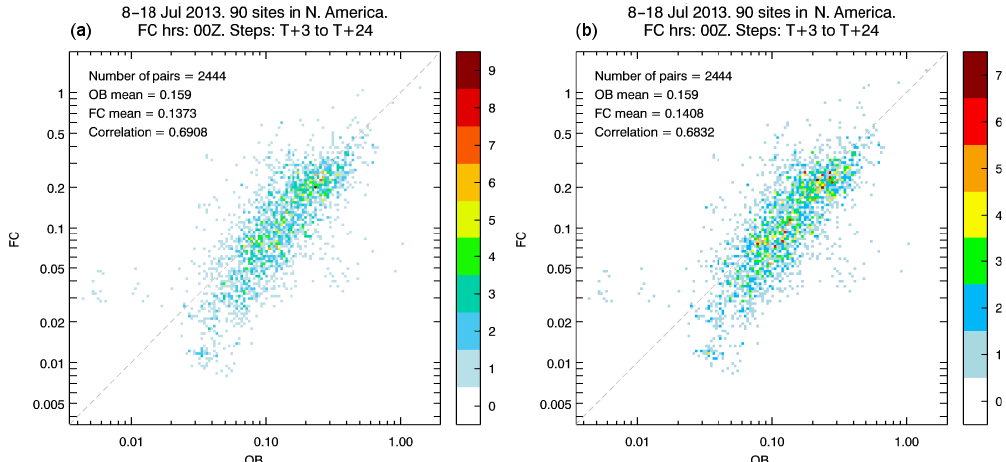
Figure 8. AOD at 550nm for the 90 AERONET stations in North America and the two CAMS simulations initialized with the operational GFAS (a) and using the new FWI-based model (b) . The model simulations are a concatenation of the first 24h